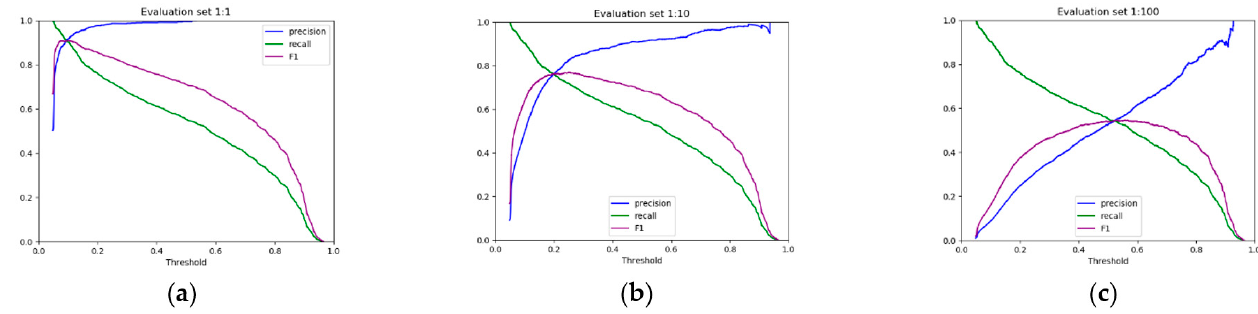
Figure 3. The precision, recall, and F1 score (the harmonic mean of precision and recall) against prediction score threshold for ( a ) 1:1, ( b ) 1:10, and ( c ) 1:100 datasets. The ‘normal’ (0.1) and ‘strict’ (0.5) score thresholds are suggested to users of miRBind.